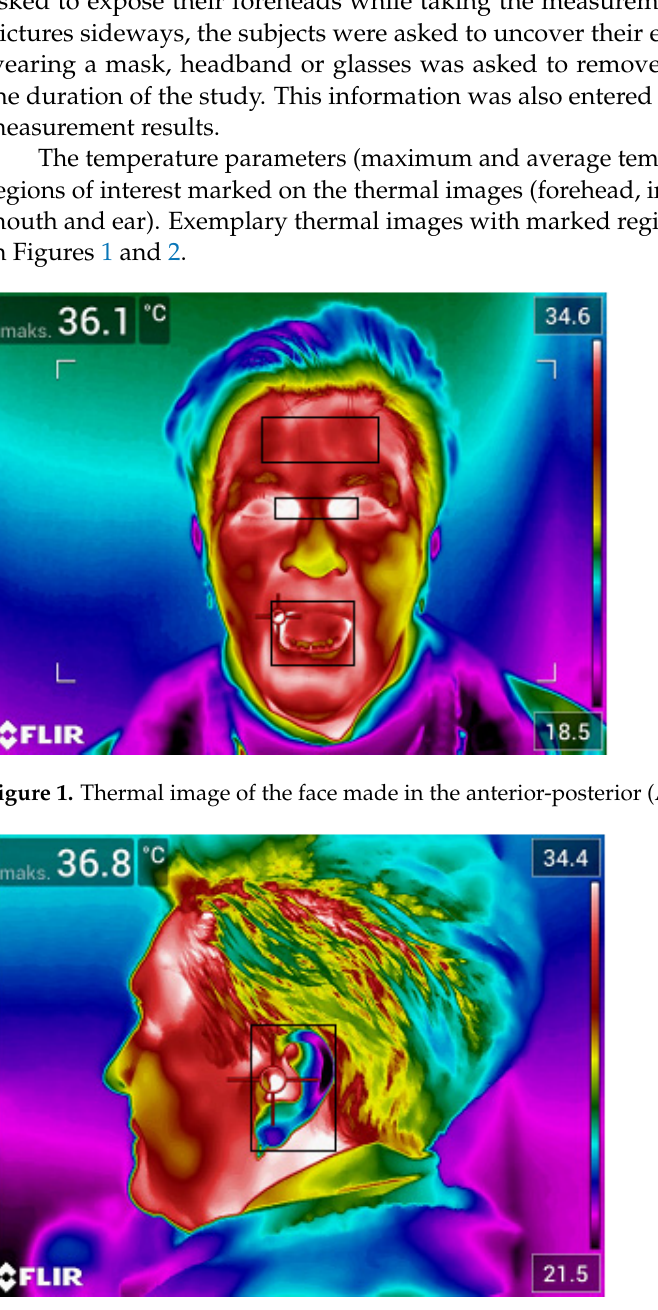
Figure 2. Thermal image of the face made in the lateral